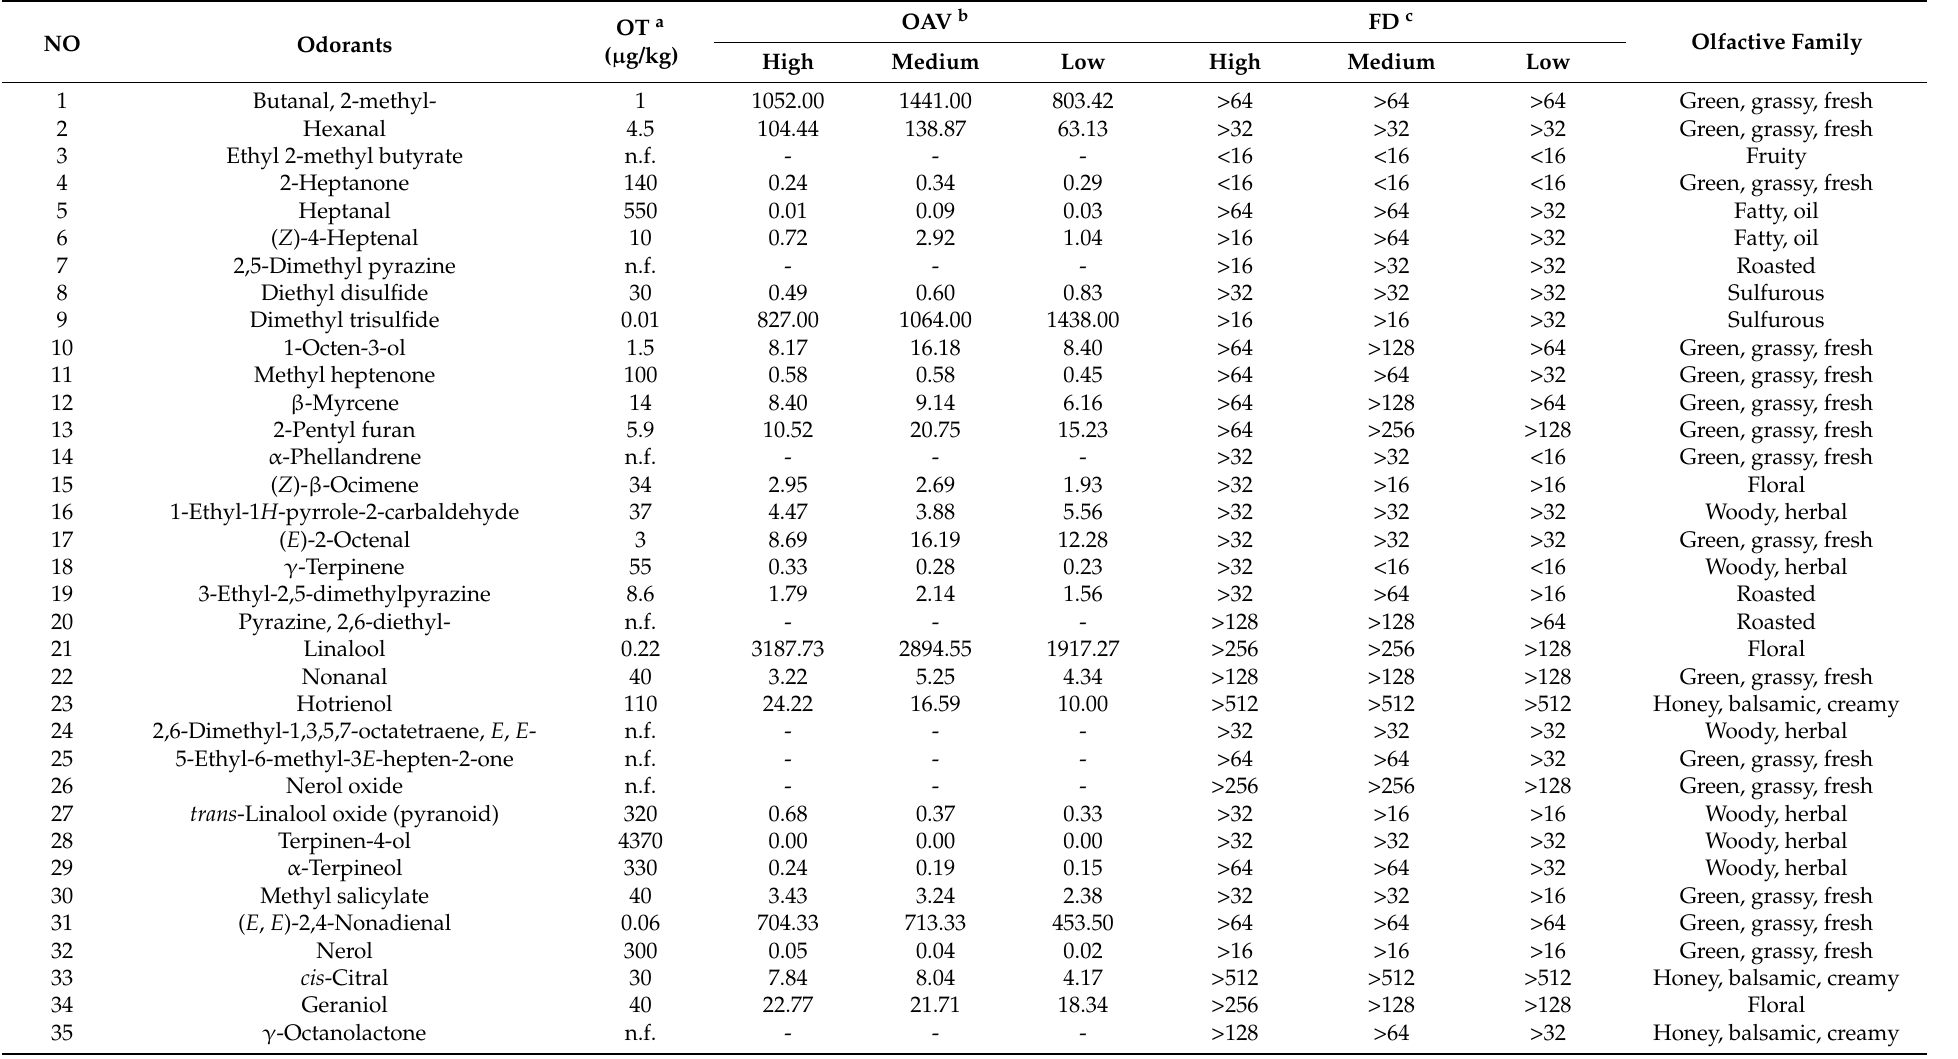
Table 2. Analysis of aroma contribution of Lingtou Dancong Oolong tea product from plants grown at different